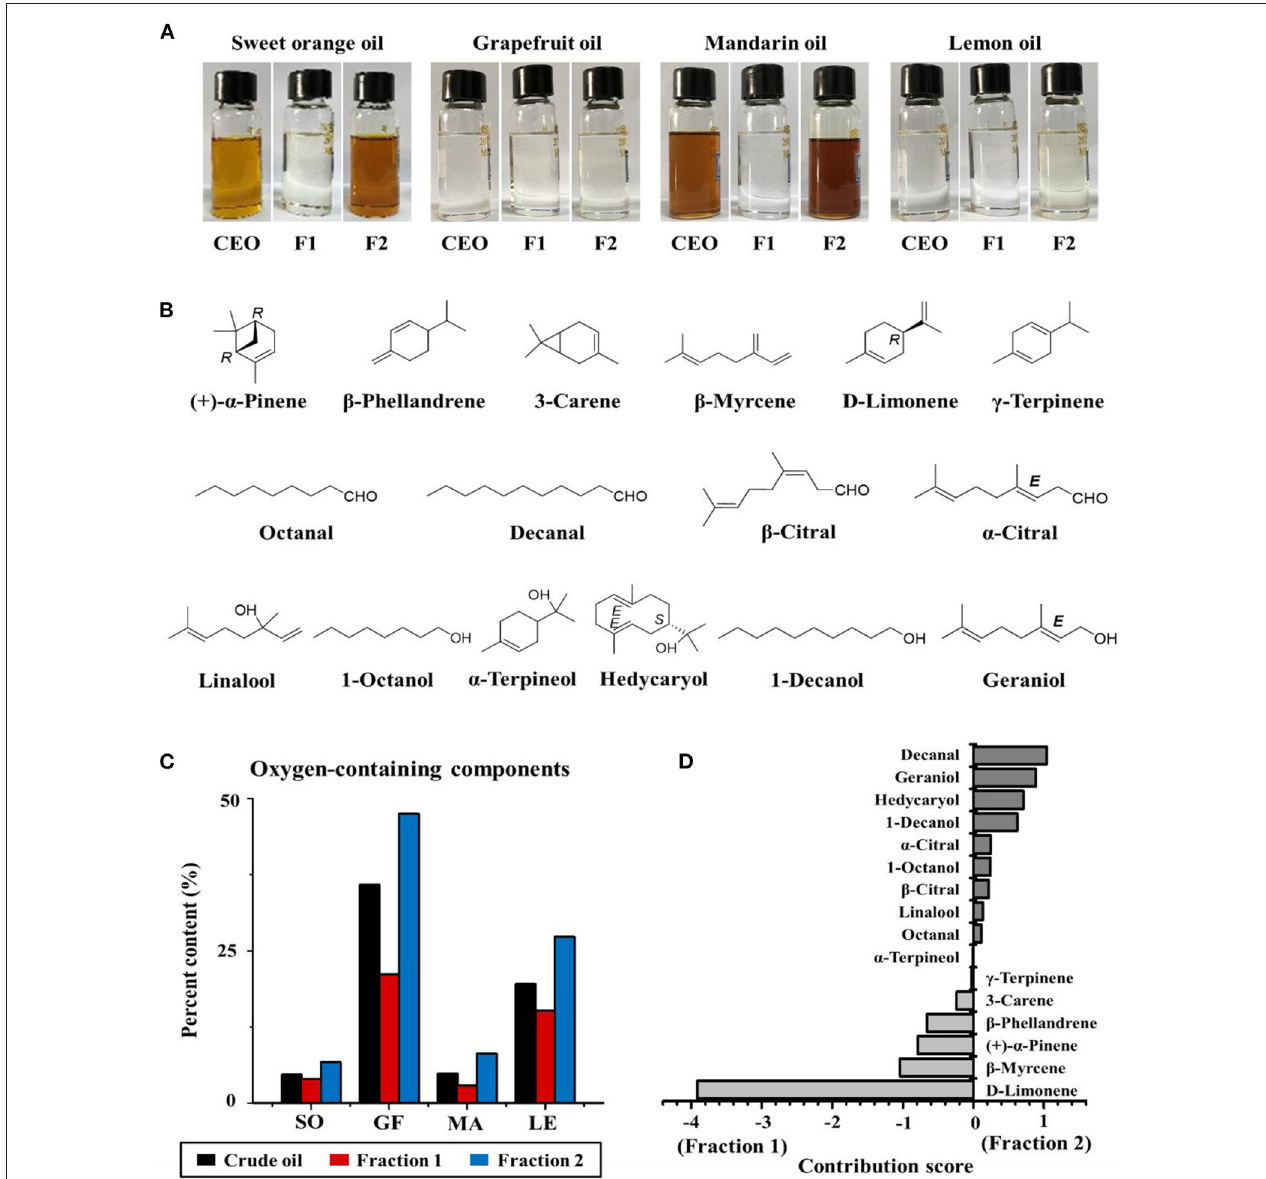
FIGURE 2 | (A) The appearance of sweet orange, grapefruit, mandarin, and lemon essential oils (CEO, F1, and F2 represent crude essential oil, Fractions 1 and 2, respectively). (B) Chemical structures of the major components of citrus EOs. (C) Percentage of oxygen-containing components in crude EOs and Fractions 1 and 2 of sweet orange (SO), grapefruit (GF), mandarin (MA), and lemon (LE). (D) Contribution score of each component to the difference between Fractions 1 and